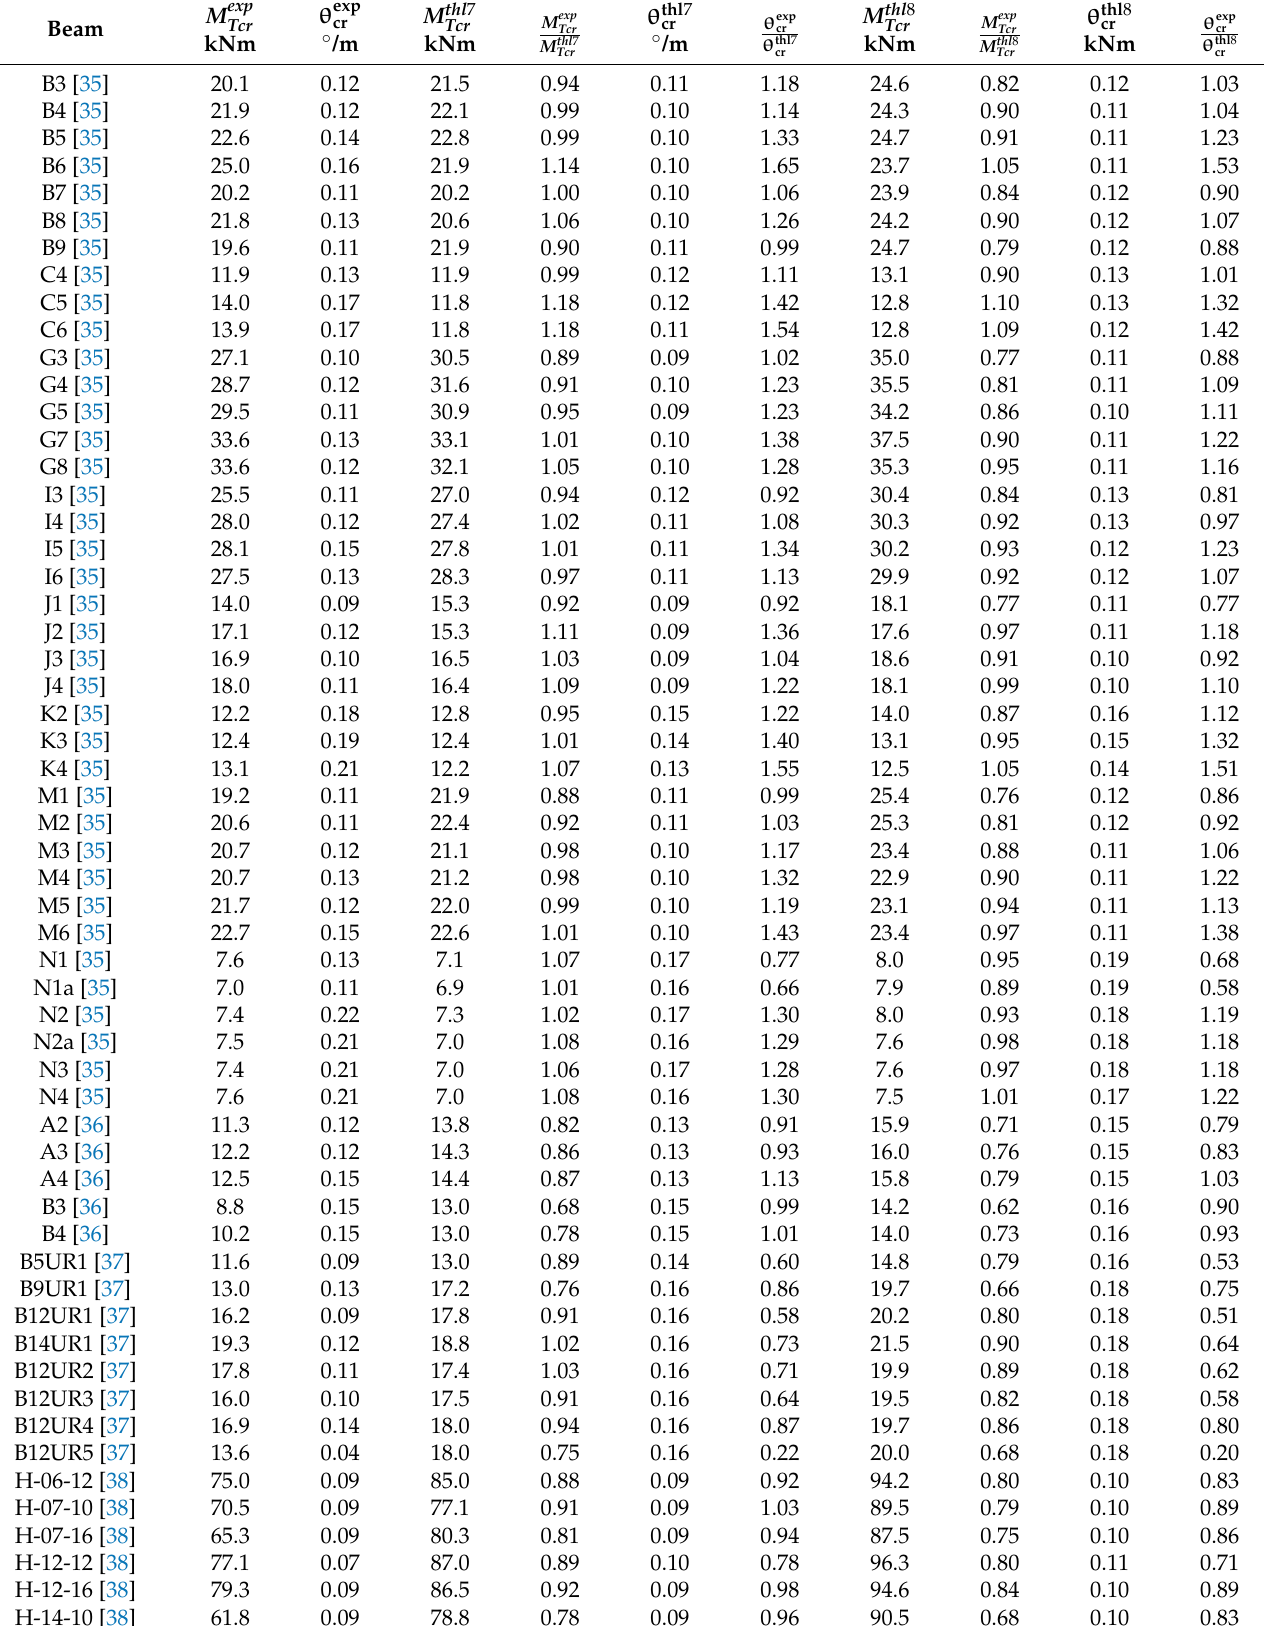
Table A4. Cracking torques and corresponding twists (smeared constitutive laws l 7 to l 8).